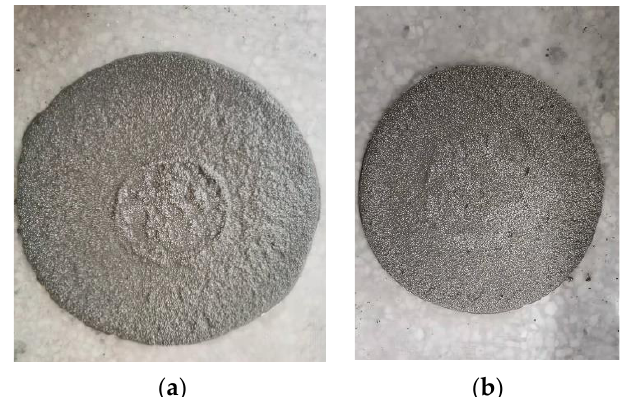
Figure 5. The bleeding rates of the lightweight CLSM: ( a ) Group 2; ( b ) Group 3.